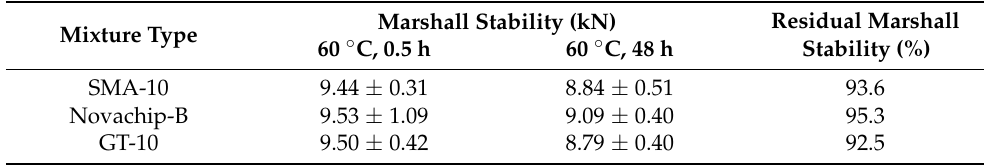
Table 3. Results of Marshall stability